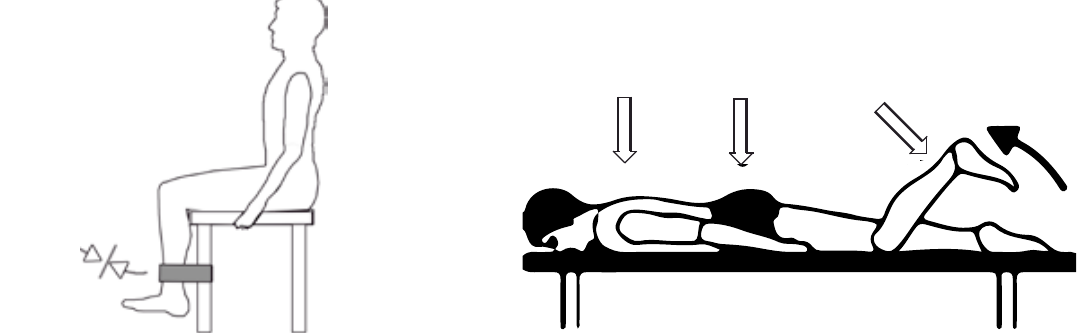
Figure 1. MVC measurement of the quadriceps muscle [35]. Figure 2. MVC measurement of the hamstring muscle [35].